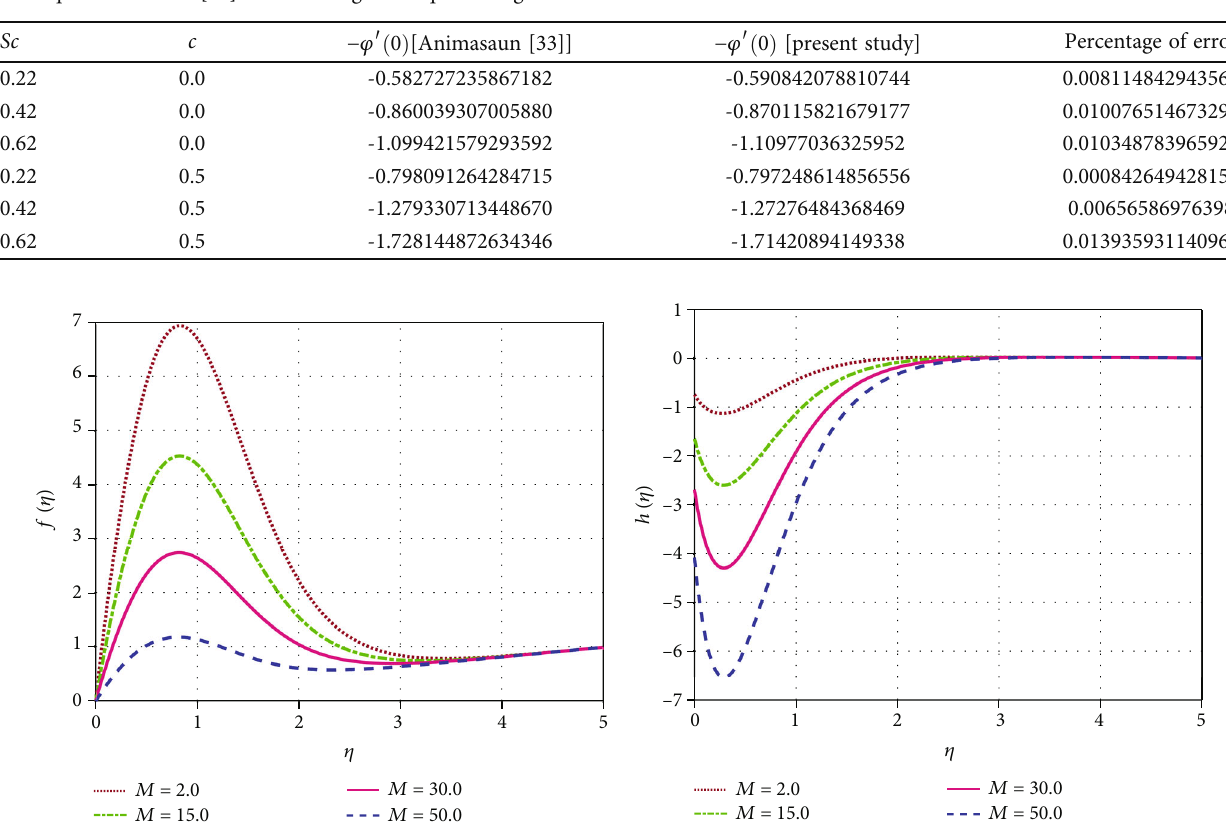
Table 9: Comparison of local mass transfer rate − φ ′ ð 0 Þ for Schmidt number ( Sc ) applying Classical Runge – Kutta along with shooting technique Animasaun [33] and shooting technique through “ ODE45 MATLAB ” .